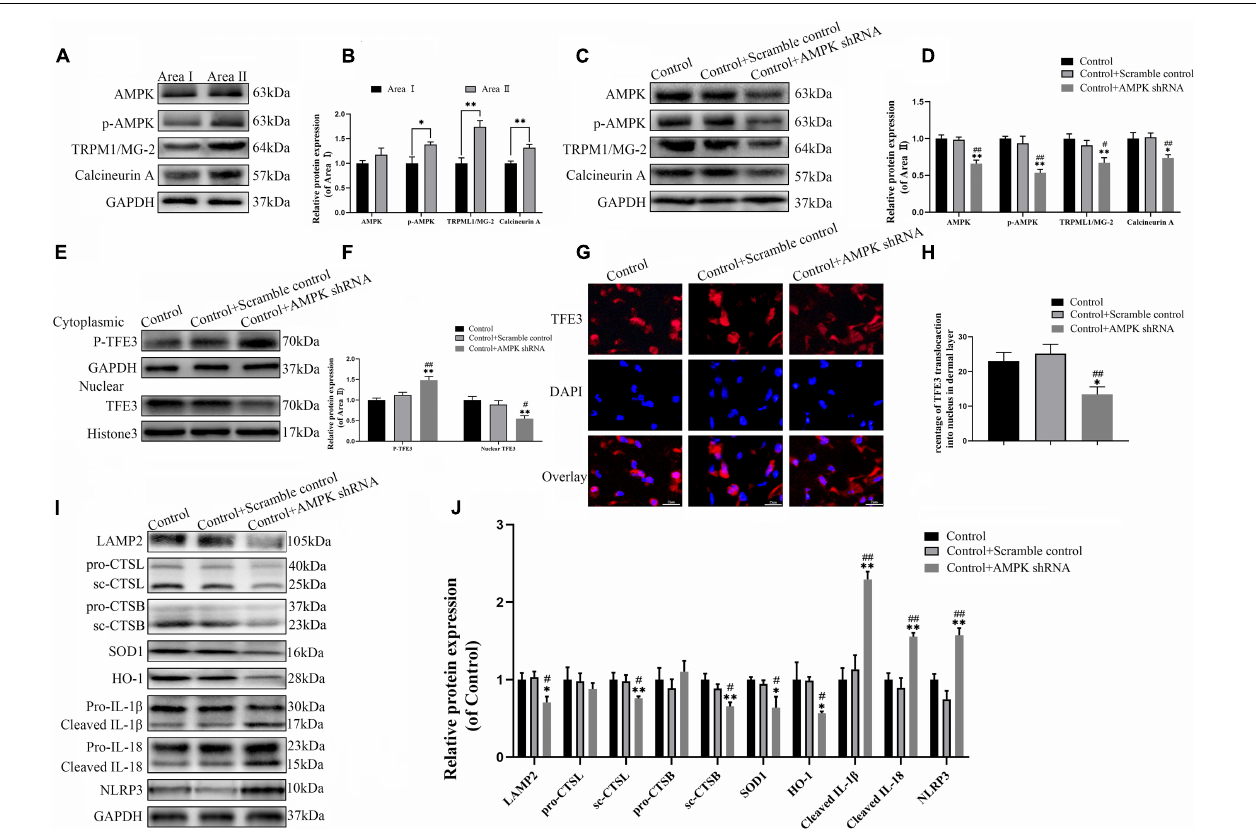
FIGURE 7 | The activity of TFE3 is regulated by AMPK-MCOLN1-calcineurin signaling pathways. (A,C) Western blotting of AMPK, p-AMPK, TRPML1/MG-2, and calcineurin in flap tissue. (B,D) Quantification of AMPK, p-AMPK, TRPML1/MG-2, and calcineurin immunoblots. (E) Western blotting of cytoplasmic TFE3 and nuclear TFE3 in flaps. (F) Quantification of cytoplasmic TFE3 and nuclear TFE3 immunoblots. (G) Immunofluorescence of nuclear translocation of TFE3 in flaps (scale bar: 25 mm). (H) Percentage of TFE3-positive cells. (I) Western blotting of LAMP2, CTSL, CTSB, SOD1, HO-1, cleaved-IL-1 β , cleaved-IL-18, and NLRP3. (J) Histograms of the optical density values of LAMP2, CTSL, CTSB, HO-1, SOD1, cleaved-IL-1 β , cleaved-IL-18, and NLRP3. Data are the mean ± SEM, n = 6 per group. * p < 0.05 and ** p < 0.01, vs. control or area II group. # p < 0.05 and ## p < 0.01, vs. control + scramble control